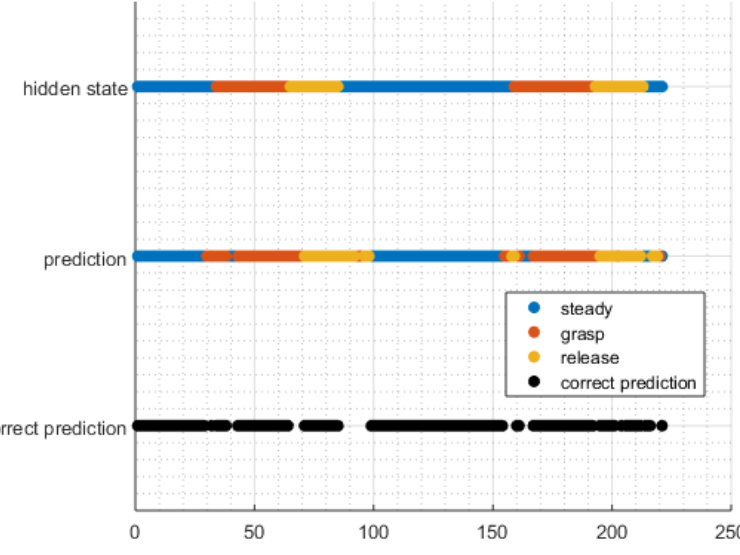
Figure 4. Example of a set of labels over the course of one trial (two grasp and release motions) using the unigram HMM method with five components. Each epoch is 125 ms, with a 100-ms overlap between adjacent epochs.